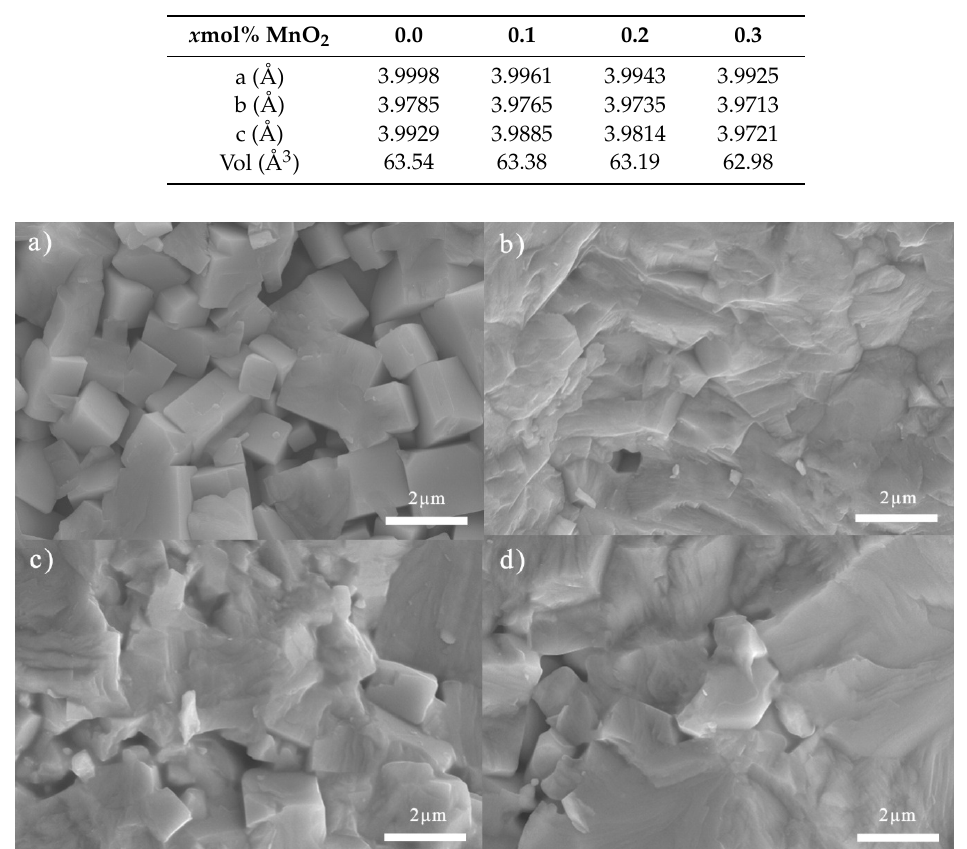
Figure 1. XRD pattern of KNLNT- x Mn ( x = 0.0, 0.1, 0.2, 0.3) ceramics: ( a ) 20–60°, ( b ) 44–47°.